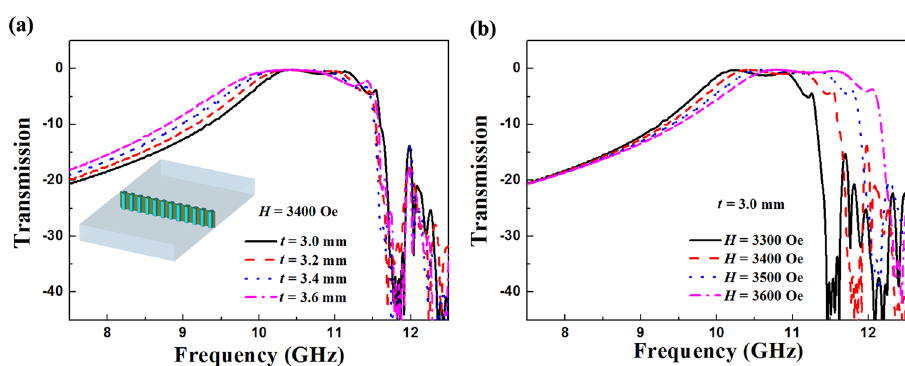
Figure 2. Simulated transmission intensity spectra of the magnetically tunable metasurface. ( a ) The ferrite rods with a series of thicknesses t . The inset shows the schematic diagram of the proposed metasurface. ( b ) The ferrite rods under a series of applied magnetic fields H